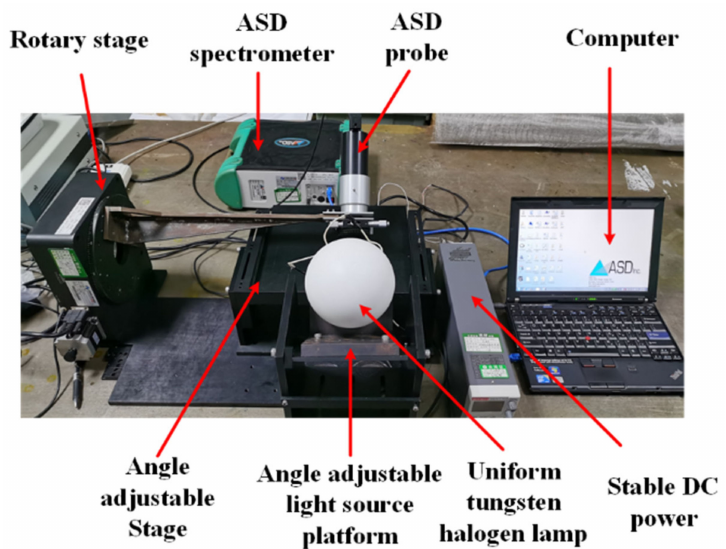
Figure 3. Multi-angle spectral reflectance measurement system. The research samples selected in the experiment are divided into two categories. The first class is vegetation leaf samples: clove leaves, shrub leaves and grass leaves. The second class is artificial objects similar to vegetation: green coatings, artificial leaves and cloth with camouflage patterns. The samples used for data acquisition are shown in Figure 4: all samples are similar in color and are green. Among them, clove leaves are large, heart-shaped, relatively flat, and smooth, and the leaves are overlapped. Shrub leaves are narrow and oval, curly, with smooth surfaces and overlapping leaves. The grass leaves are thin, narrow, long strip, rough surface, and the leaves are staggered. The surface of the green coating is flat and has a fine texture. The fake leaves are human-made, simulated landscapes, and their surfaces are rough and imitate the leaves’ grain. The camouflage cloth is green as a whole, composed of light green, dark green, brown and yellow.